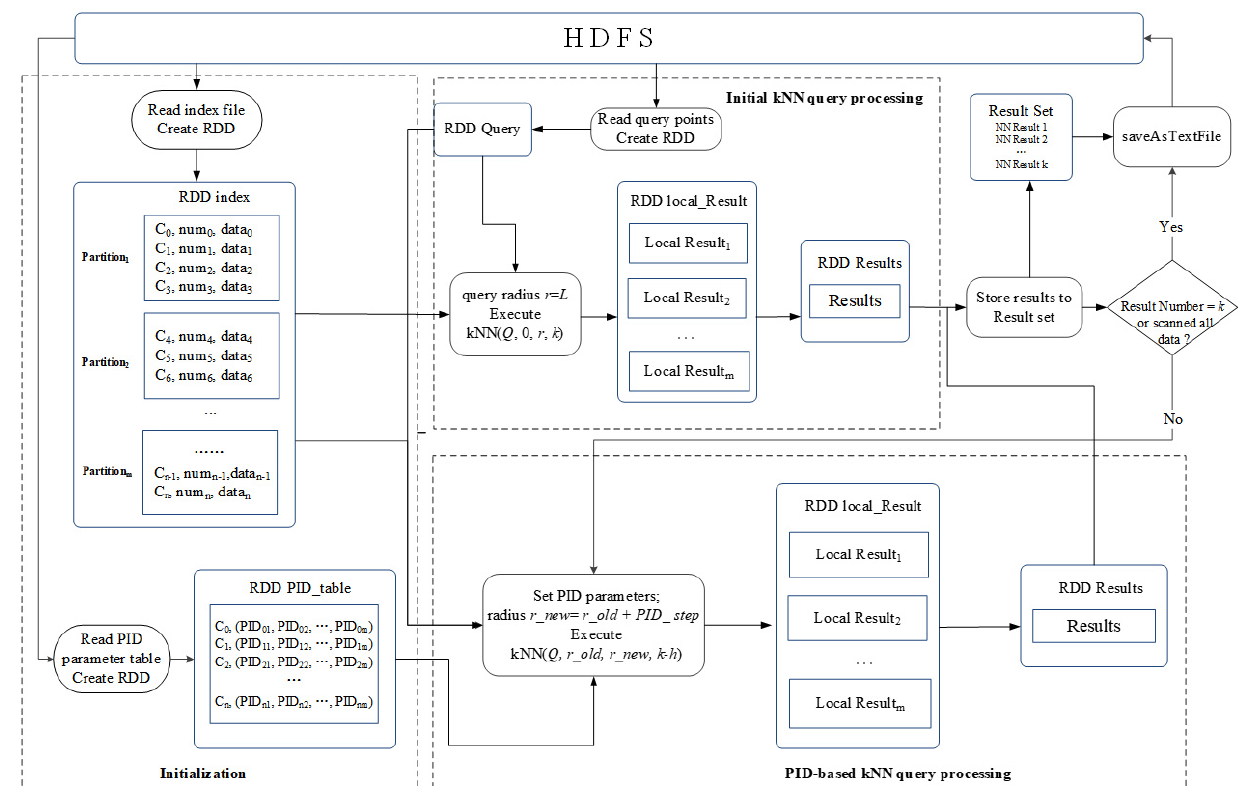
Figure 4. Overall framework of PIDKDD algorithm.